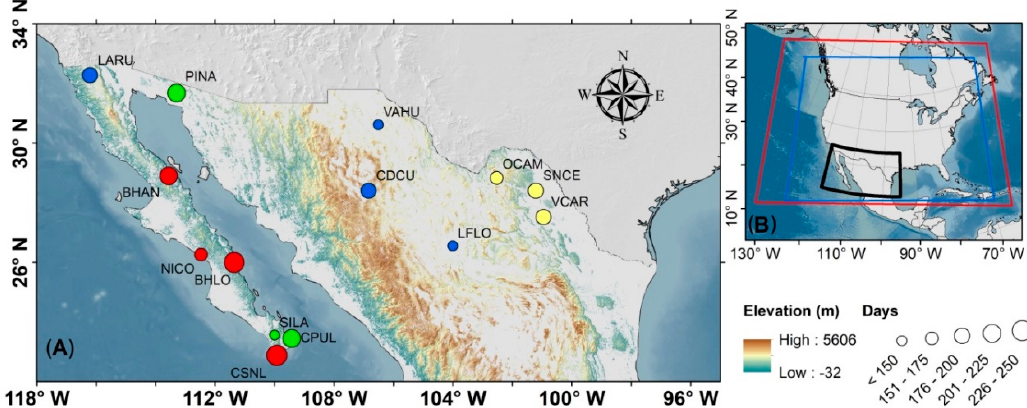
Figure 1. ( A ) Study area and ( B ) domain of the North American Mesoscale Forecast System (NAM) (red line) and the Rapid Refresh Model (RAP) (blue line) mesoscale models. Shaded areas represent terrain height (m) with slopes greater than 5°. The size of the circle indicates wind speed days >3 m/s. The color in the circles indicate the regions: the Baja California Peninsula in red, Gulf of California in green, Plateau in blue and Northeastern Mexico in yellow. Topographic slopes were calculated as the magnitude of the gradient for the GTOPO30 [32] digital elevation model with a horizontal grid spacing of 30 arc seconds (~1 km).